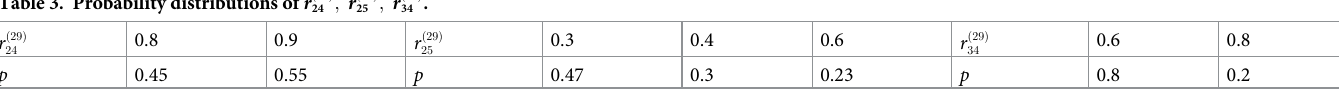
; r ð 29 Þ ; r ð 29 Þ . 24 25 34